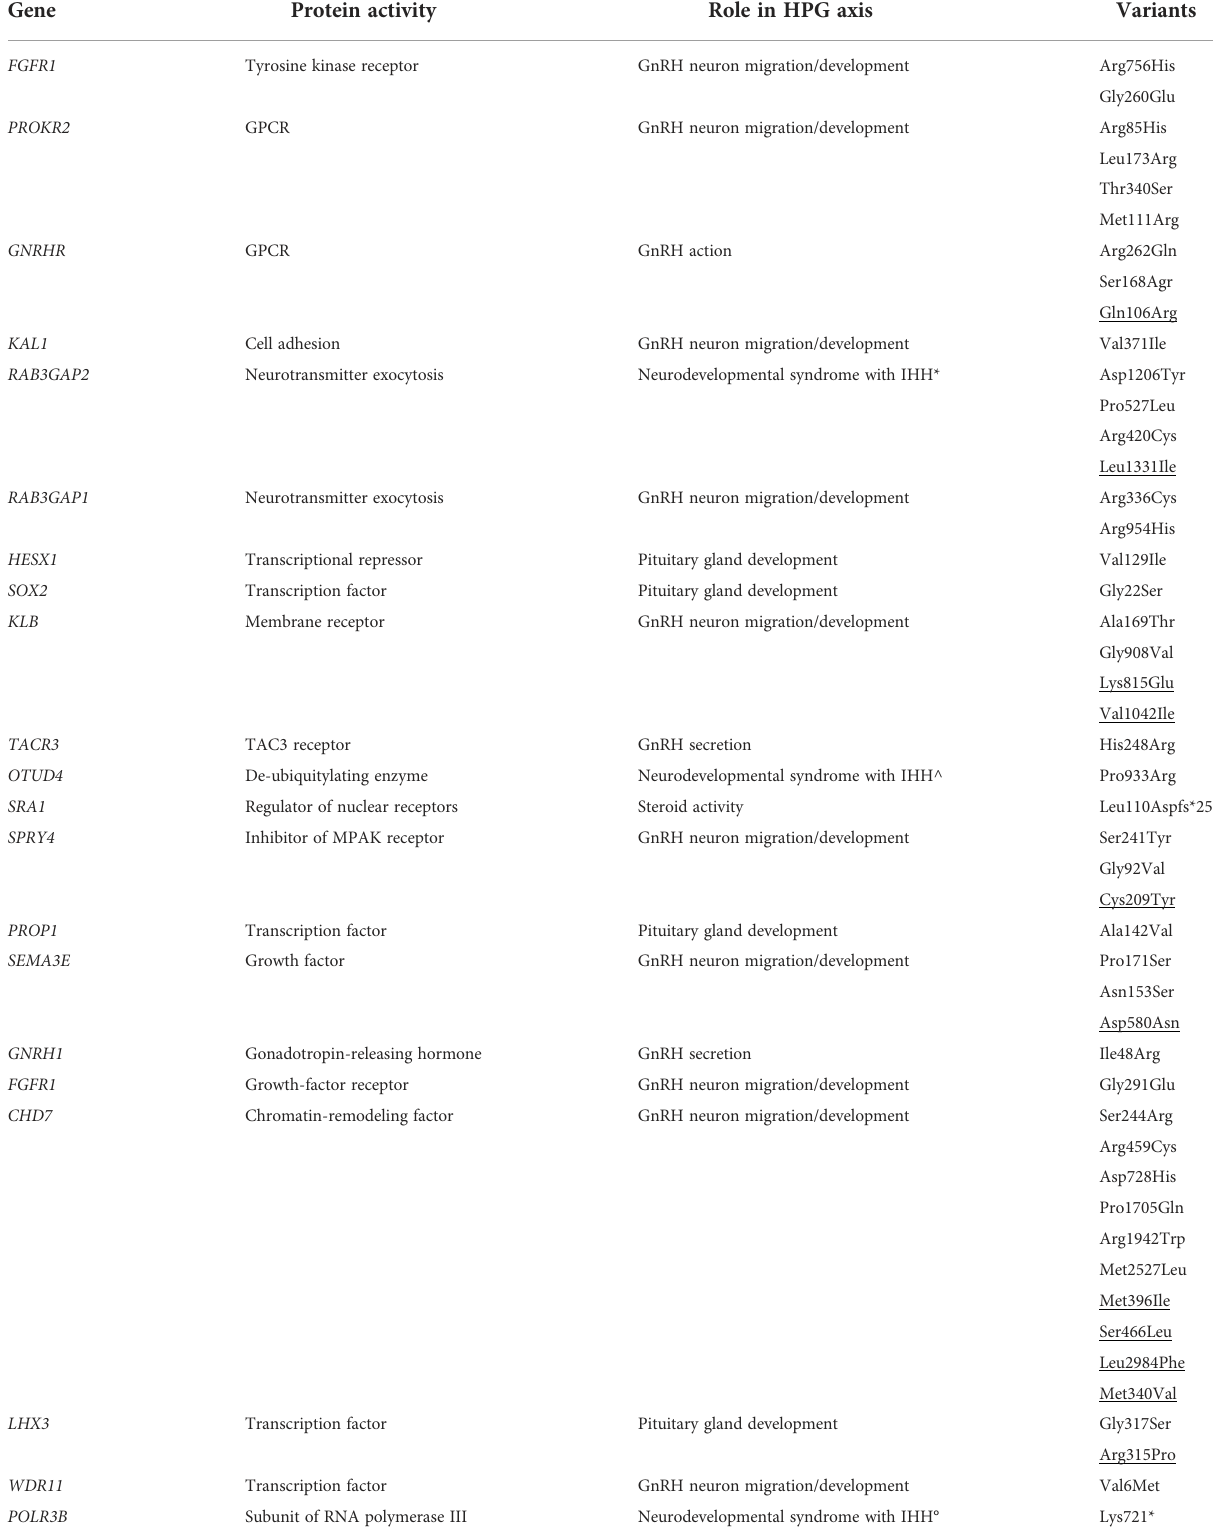
TABLE 1 Rare variants in IHH-related genes identi fi ed in FHA patients according to Caronia et al., 2011 and Delaney et al.,